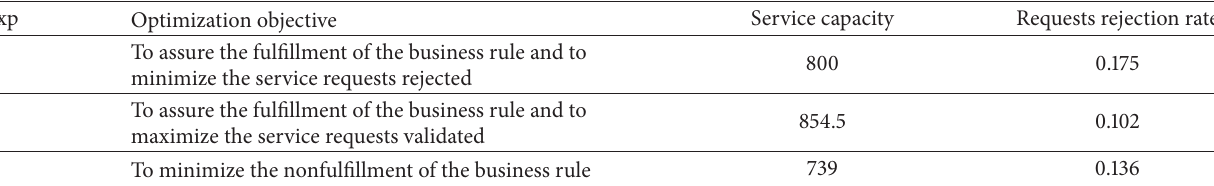
Table 3: Optimization experiments.